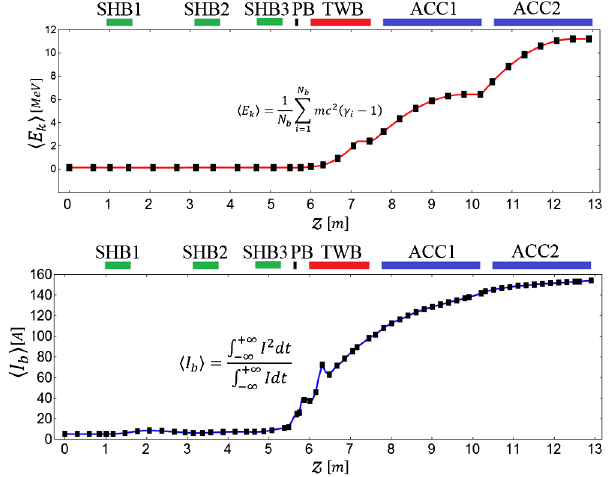
FIG. 11. PARMELA simulation results for the variations of the average bunch energy (top panel) and its current (bottom panel) in the focusing channel designed for the CLIC drive beam injector.